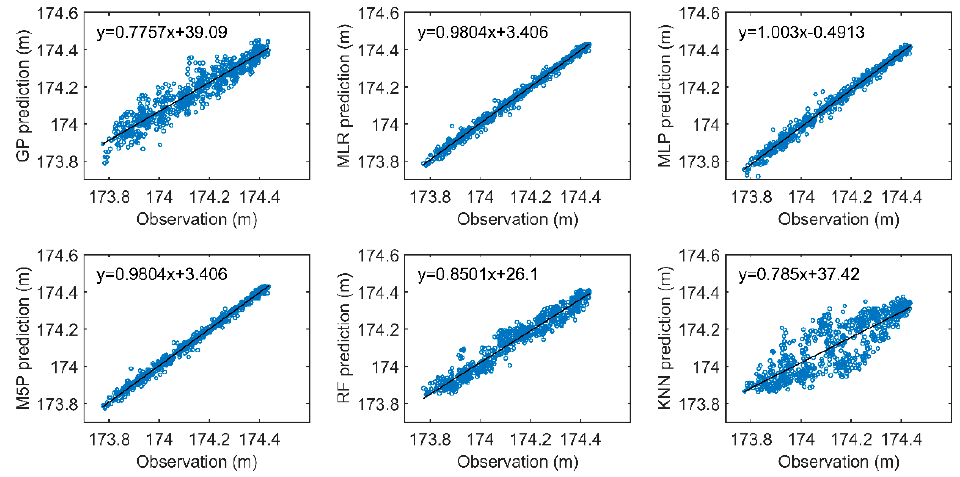
Figure 6. Scatter plots of the observations and predictions from GP, MLR, MLP, M5P, RF, and KNN models during the testing period from January 1st 2013 to December 31st 2014.